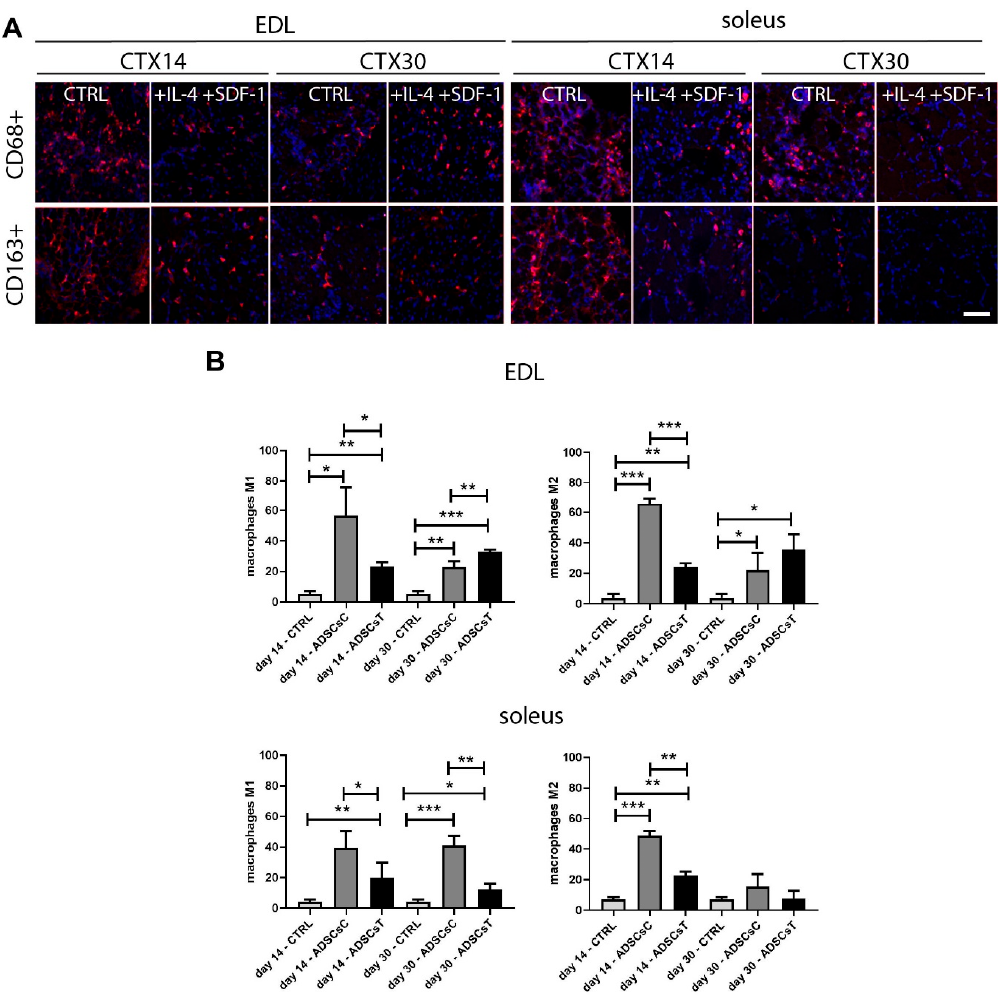
Figure 6. Inflammation development of EDL and soleus rat muscles injected with control (ADSCsC) as well as IL-4 and SDF-1 treated rADSCs (ADSCsT). ( A ) Localization of M1 (CD68+) and M2 (CD163+) macrophages in regenerating muscles at days 14 and 30 of regeneration; bar: 50 µm. ( B ) Number in the field of view of M1 (CD68+) and M2 (CD163+) macrophages in regenerating muscles at 14 and 30 day of regeneration. For each experimental group n = 4. Data are presented as mean ± SD. * represents results of Student’s t -test: * p ≤ 0.05; ** p ≤ 0.01, *** p ≤ 0.001.